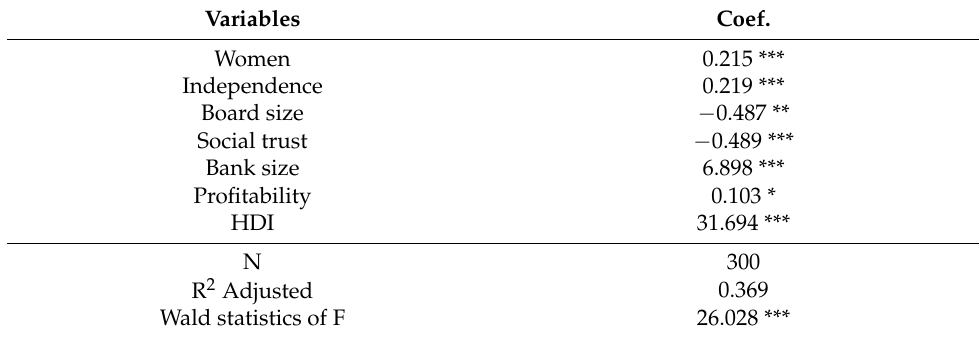
Table 5. Results of the regression equations for ESG